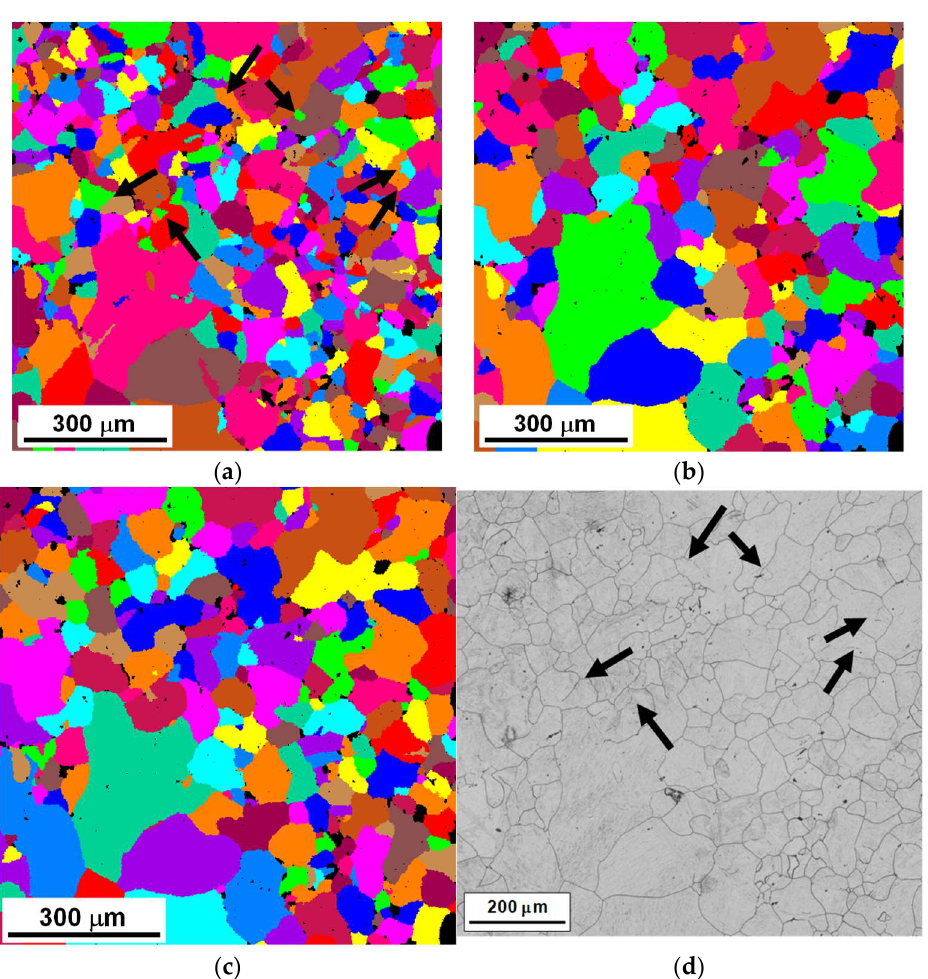
Figure 8 . Unique grain color maps obtained for the austenite phase from the results of the reconstruction applied to the martensitic scan data from Figure 2c (Step size = 1.5 μm) using a tolerance angle for a grain boundary definition of 10° and different criteria for twin boundary exclusion: ( a ) All high angle grain (>10°) boundaries considered; ( b ) twins excluded (misorientation criterion (5° tolerance)); ( c ) twins excluded (misorientation criterion (5° tolerance) + {111} plane coincidence criterion (1° tolerance angle)); ( d ) optical micrograph. Black areas correspond to non-reconstructed regions. In ( a , d ) arrows mark boundaries which are present in ( a ) but not in ( b ) and/or ( c ), and which appear faintly or do not close to define grains in the optical micrograph in ( d ).